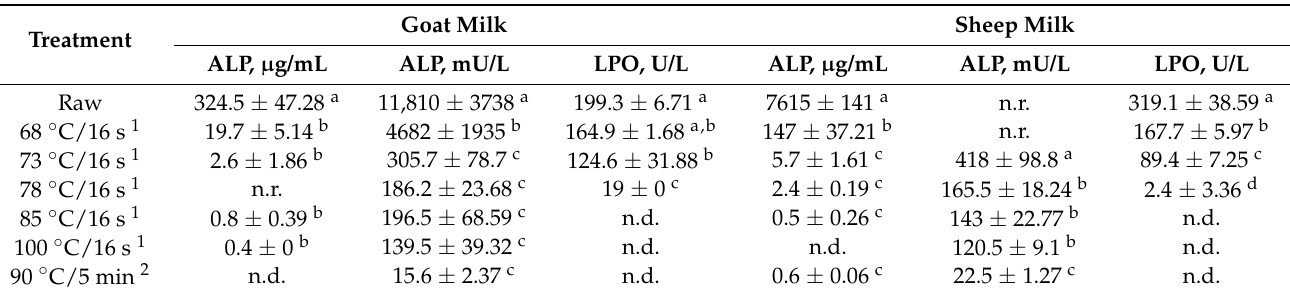
Table 6. Alkaline phosphatase (ALP) activity determined by the photometric ( µ g/mL) and by the fluorometric (mU/L) methods, and lactoperoxidase (LPO) activity (U/L) in heat-treated goat and sheep milk; means ± standard deviation. G, goat milk; S, sheep milk. Different letters indicate significant differences (LSD, p < 0.05) between the means of different heat treatments. n.r., not recorded; n.d., not detected. Goat Milk Sheep Milk Treatment ALP, µ g/mL ALP, mU/L LPO, U/L ALP, µ g/mL ALP, mU/L LPO, U/L Raw 324.5 ± 47.28 a 11,810 ± 3738